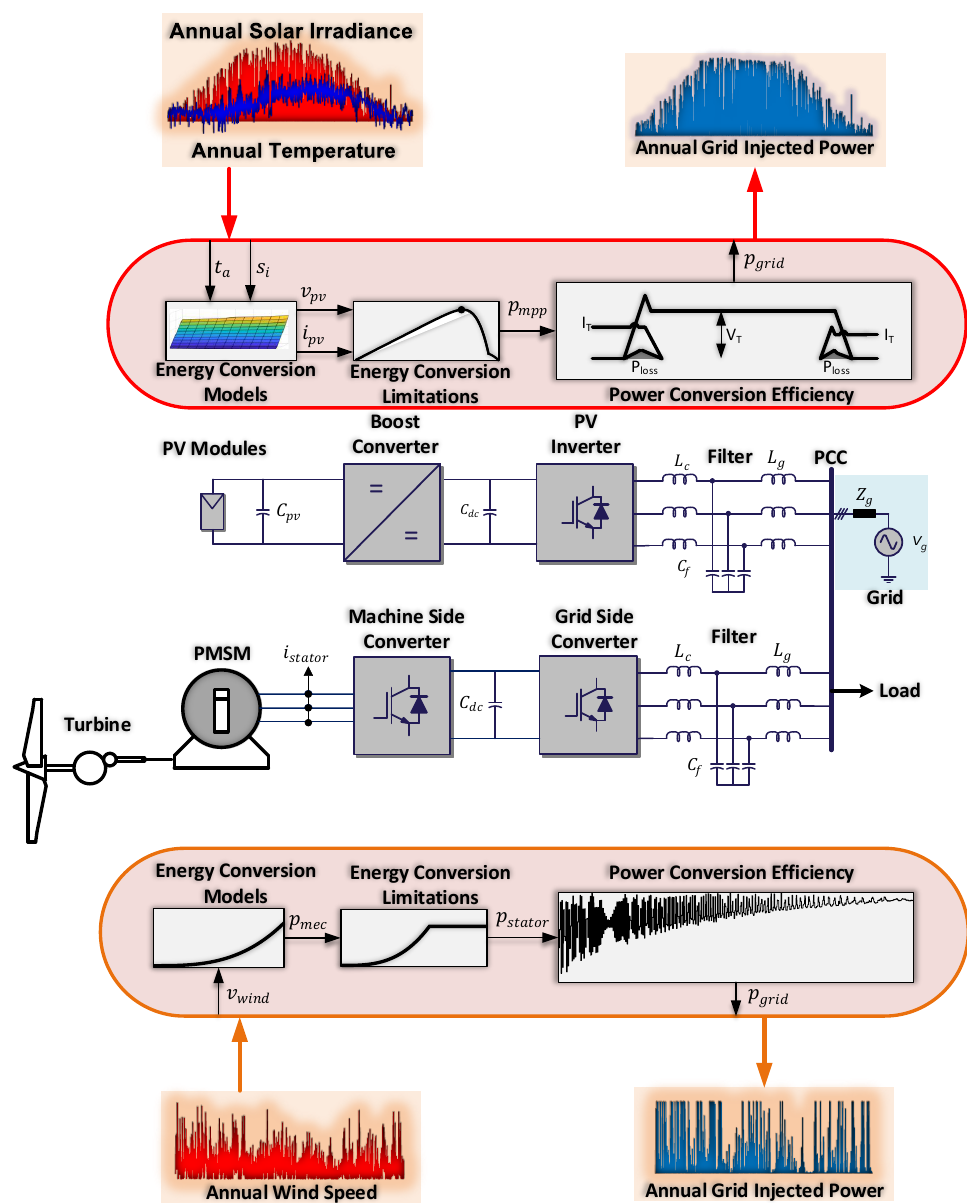
Figure 3. Diagram outlining the methodology used to obtain the available generation capacity in the network shown in Figure 2, where the blue PV generator input curve is the annual temperature and the red input curve is the annual solar